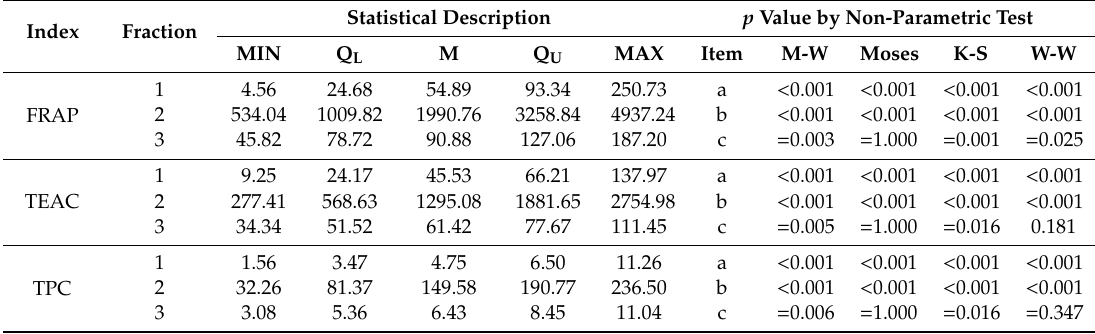
Table 3. Comparison among FRAP, TEAC, and TPC of di ff erent tea